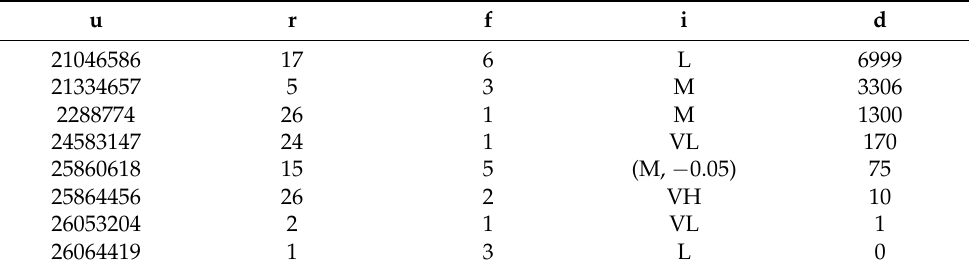
Table 6. Extract of TU.